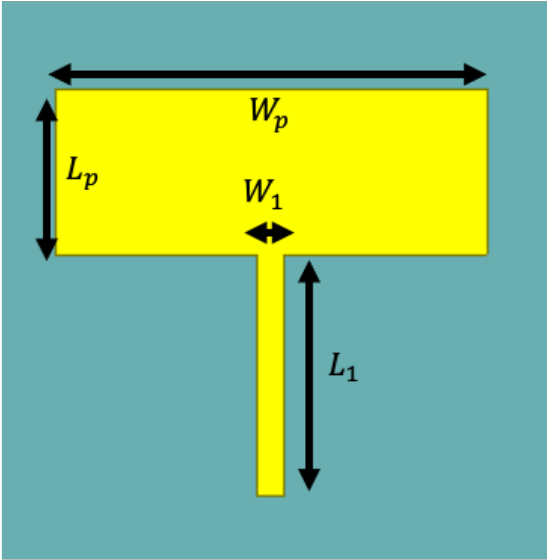
Figure 3. Conventional microstrip line chip antenna structure. (The parameters are: 𝐿 𝑝 = 150 μm , 𝑊 𝑝 = 90 μm , 𝐿 1 = 210 μm , and 𝑊 1 = 25 μm .)